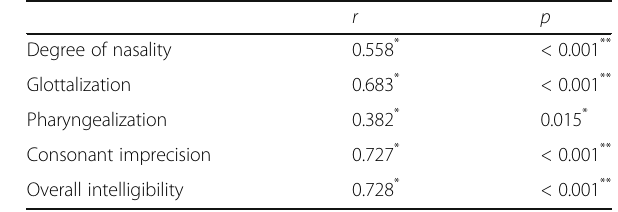
Table 6 Correlation between age and nasometer values Nasometer values